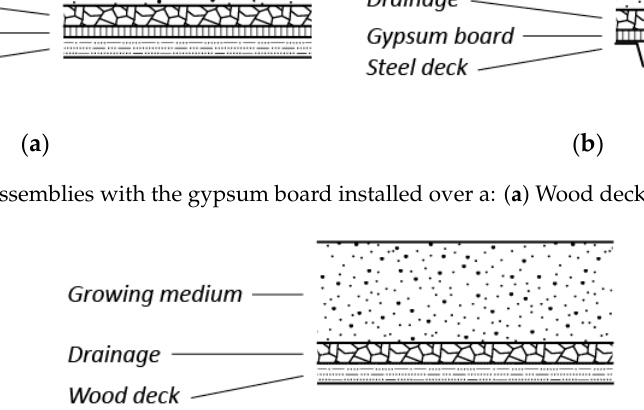
Figure 2. Assembly installed over a wood deck, without gypsum board.